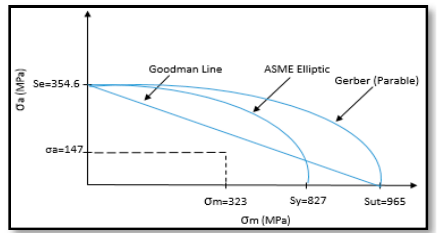
Figure 1. Goodman, Gerber and ASME failure